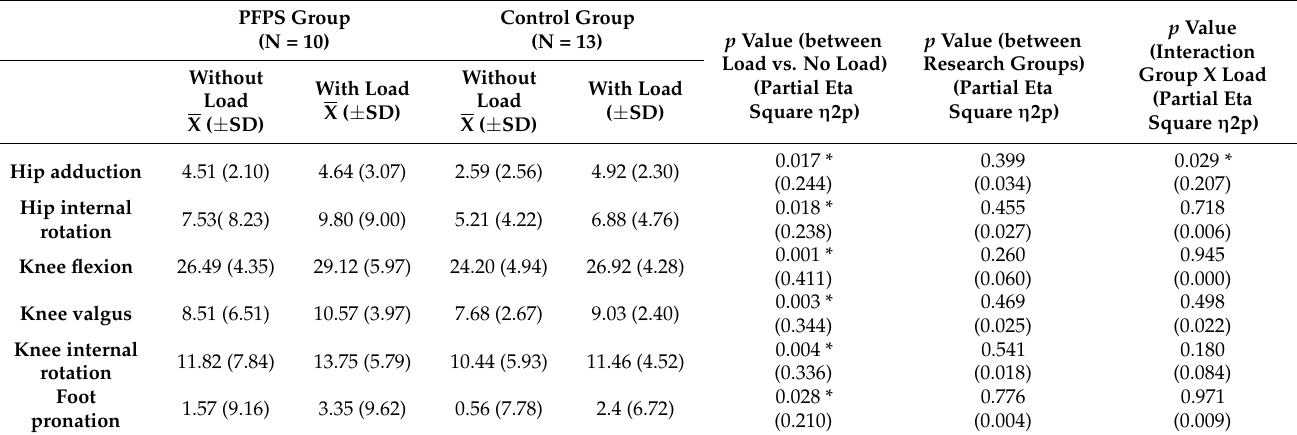
Table 2. Joint maximal angle parameters with and without load according to research groups and load condition (right leg, in degrees).